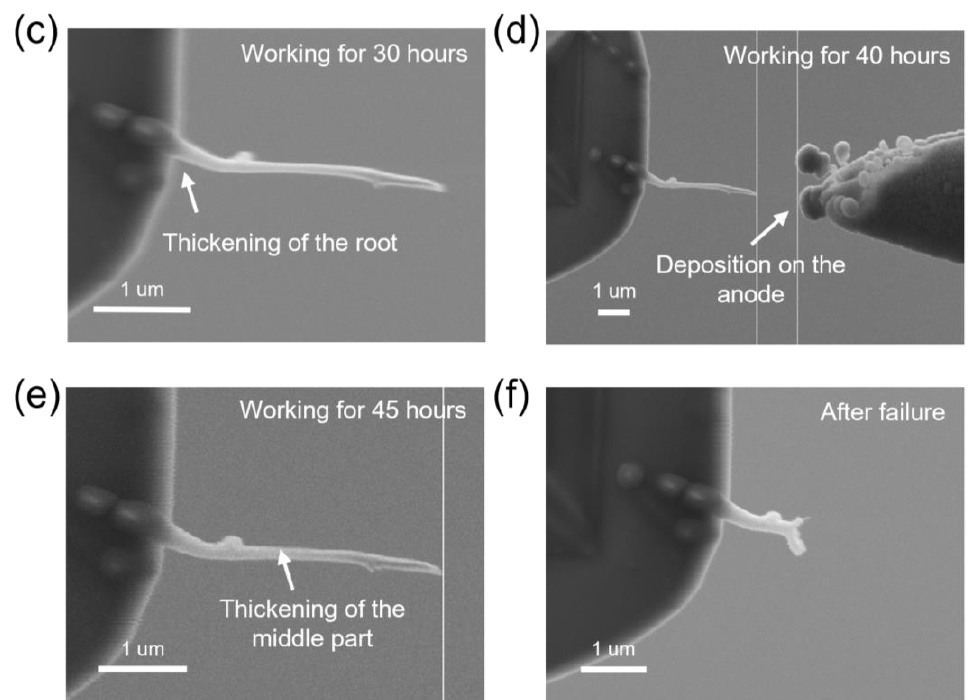
Figure 8. Morphological evolution of the hybrid-nanowire-based electron source during the fatigue test. ( a ) SEM image of the nanowire after working for 10 h, with a spindle-shaped tip and a thin middle part; ( b ) SEM image after working for 20 h — the nanowire is bent by 21.7°; ( c ) SEM image after working for 30 h —a thickening of the nanowire’s root can be found; ( d ) SEM image of electrodes after working for 40 h — some deposited structures appear on the surface of the anode; ( e ) SEM image of the nanowire after working for 45 h; (f) image of the nanowire after failure.